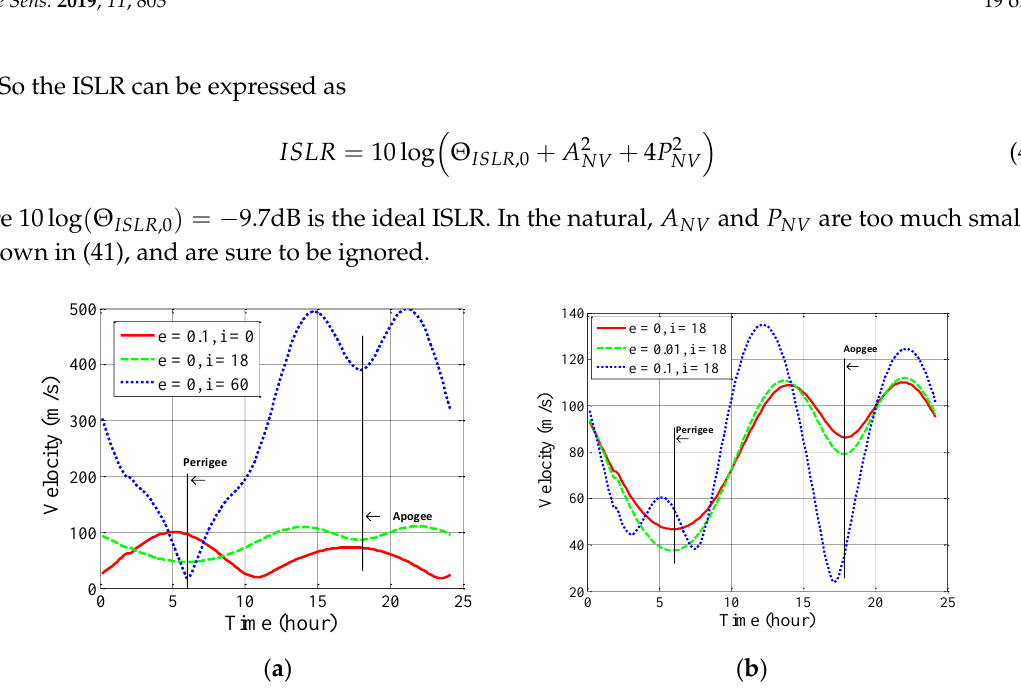
Figure 10. Beam-foot velocity variations of GEO SAR with different orbital configurations. ( a ) Different orbital inclinations and ( b ) different eccentricity in case of 18° inclination.